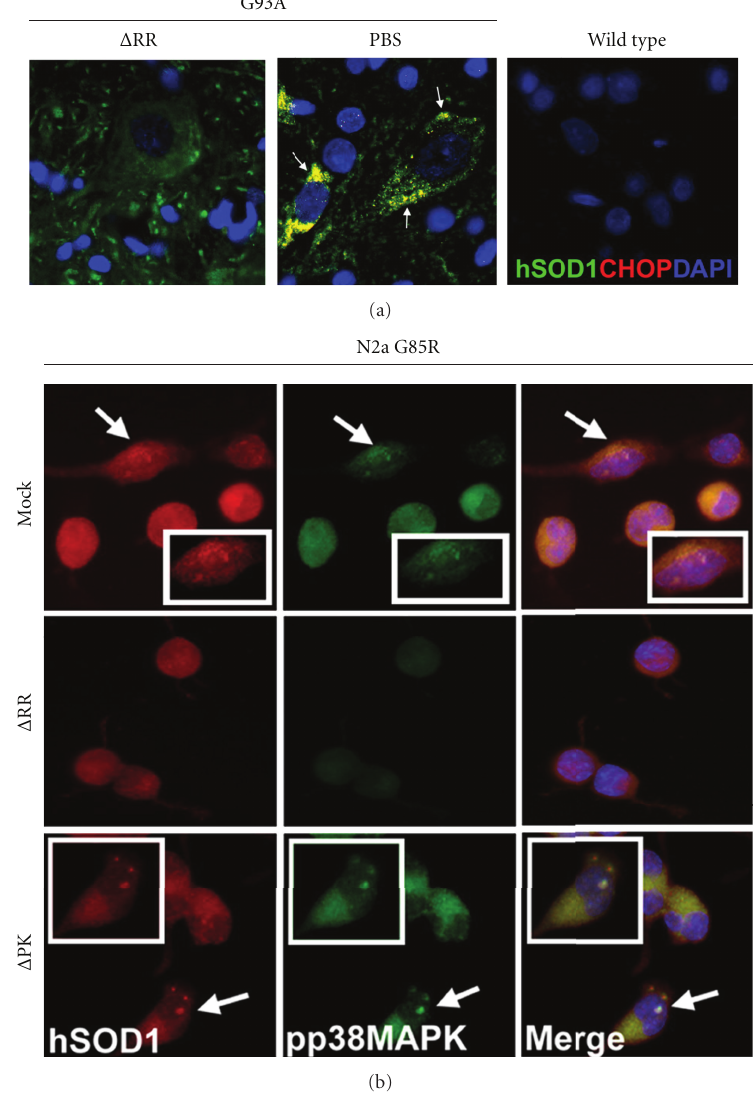
Figure 2: The ICP10PK vector Δ RR inhibits UPR. (a) mSOD1 (G93A) transgenic rats were treated with Δ RR (10 7 pfu; 100 μ L) or an equal volume of PBS in both hind limbs by intramuscular injection beginning at age of 85 days. The Δ RR-treated G93A rats lived significantly longer than their PBS-treated counterparts with a median survival of 195 and 154 days, respectively ( P < 0 . 001 by log-rank Mantel-Cox analysis). Serial sections from the L4-L5 region collected on day 153 were stained in double immunofluorescence with antibodies to human SOD1 (Alexa Fluor 488 conjugated secondary antibody; green) and CHOP (Alexa Fluor 594 conjugated secondary antibody; red). DAPI nuclear staining is blue. Only the PBS treated animals showed evidence of aggregates containing CHOP and mSOD1 co-localization. Scale bar = 10 μ m. (b). Neuronally di ff erentiated N2a cells that were stably transfected with another mSOD1 mutant (G85R) were mock infected with PBS or infected with Δ RR or a vector that lacks ICP10PK ( Δ PK) and treated with H 2 O 2 (100 μ M; 2hrs) to induce oxidative stress. N2a cells stably transfected with the wt SOD1 were studied in parallel and served as control. At 24 hrs after infection the cells were stained by double immunofluorescence with Alexa Fluor 594 conjugated SOD1 antibody (red) and Alexa Fluor 488 conjugated pp38MAPK antibody (green). DAPI nuclear stain is in blue. Scale bar = 10 μ m. Aggregates are not seen in the Δ RR-treated cells, associated with the inhibition of p38MAPK phosphorylation